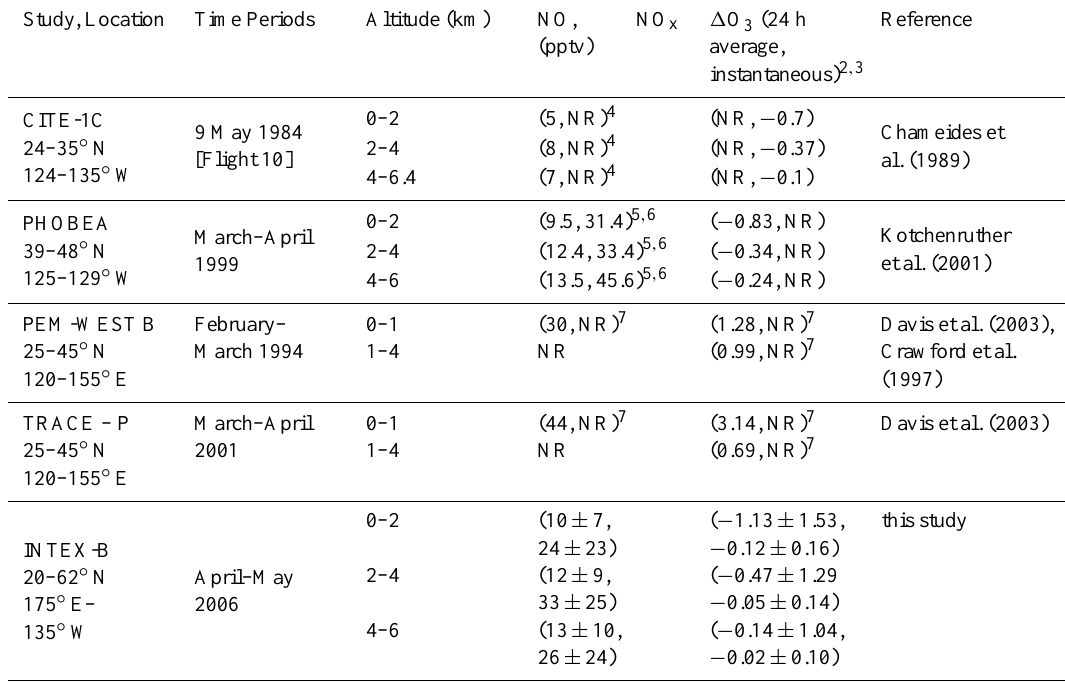
Table 1. Model calculated net ozone production rates ( 1 O 3 ), constrained by aircraft observations made in the troposphere over the Eastern, Central and Western North